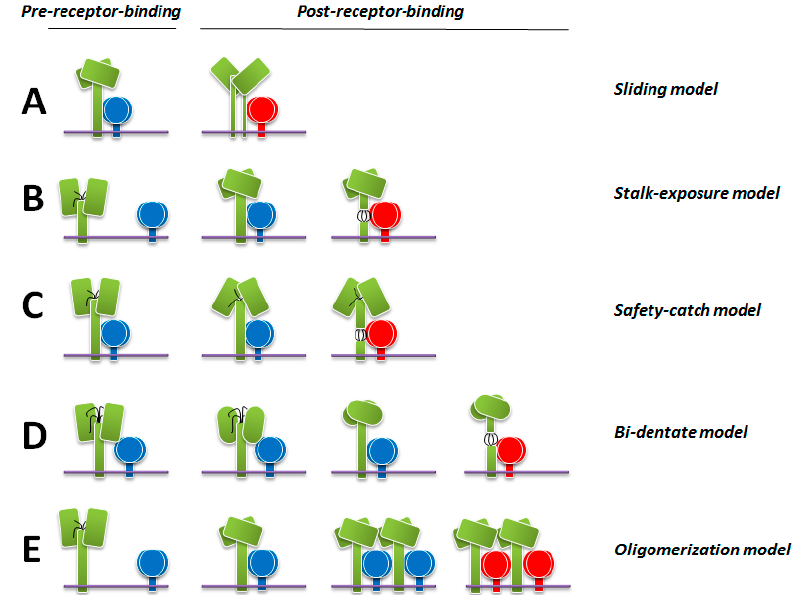
Figure 4. Models of F activation by paramyxovirus attachment proteins. ( A – E ) Latest models have proposed how attachment protein of different members of the Paramyxovirinae subfamily activates F as a consequence of attachment protein ‐ receptor binding. Importantly, all models predict a receptor ‐ induced overall re ‐ positioning of the head regions upon receptor engagements, which may then act as a universal core mechanism for F activation (first described by Bose and colleagues [122]). H tetramers are colored in green. Pre ‐ activated F and activated F are highlighted in blue and red, respectively. In model ( D ) (bi ‐ dentate model) the conformational changes occurring within the head domain prior to heads’ re ‐ positioning are represented by oval structures. The attachment protein stalk regions that are implicated in F activation are shown as black lines (models B – D ).